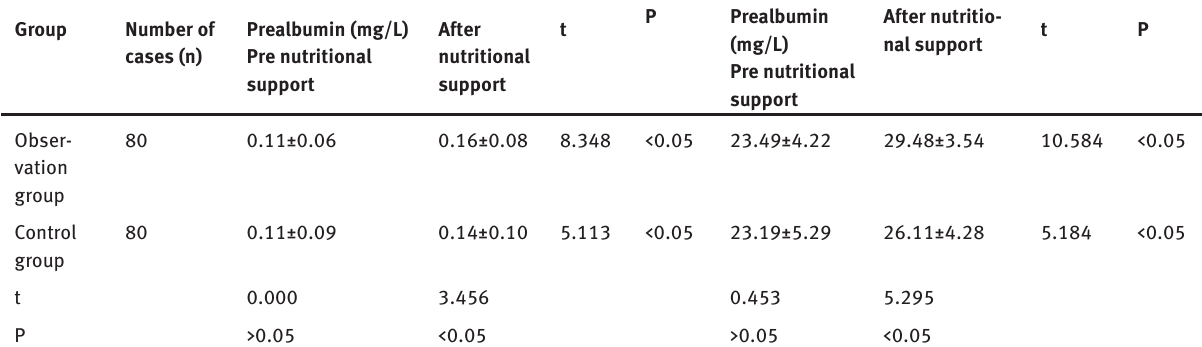
Table 3: Comparison of nutrition index (standard plus standard deviation) between two groups before and after nutritional support